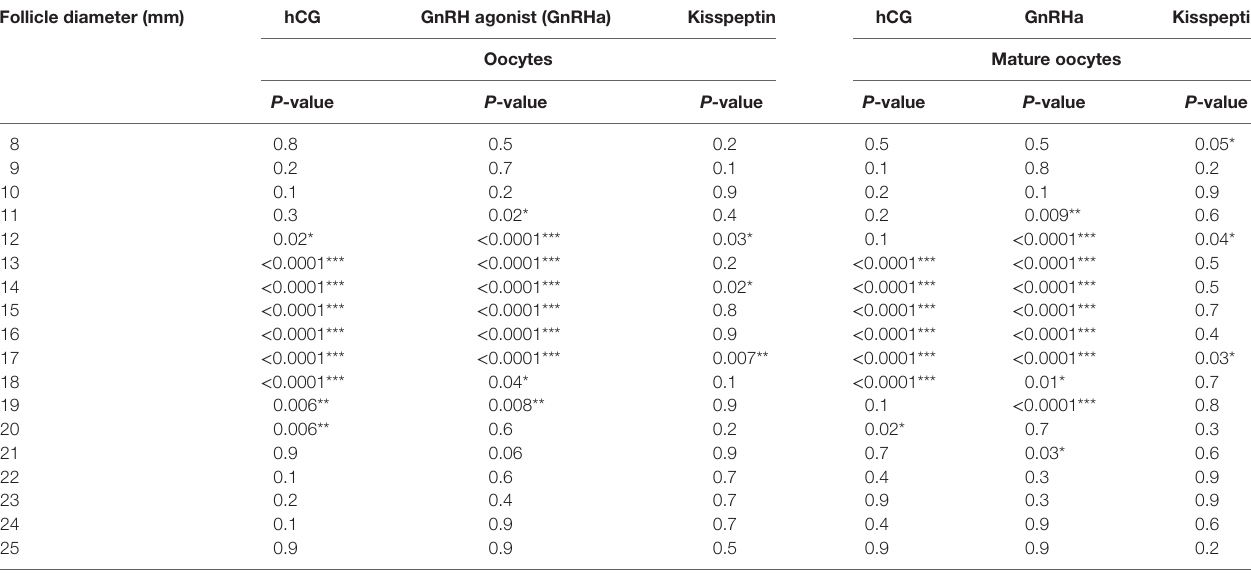
Table 2 | Generalized linear model of the number of oocytes and the number of mature oocytes retrieved by follicle diameter. Follicle diameter